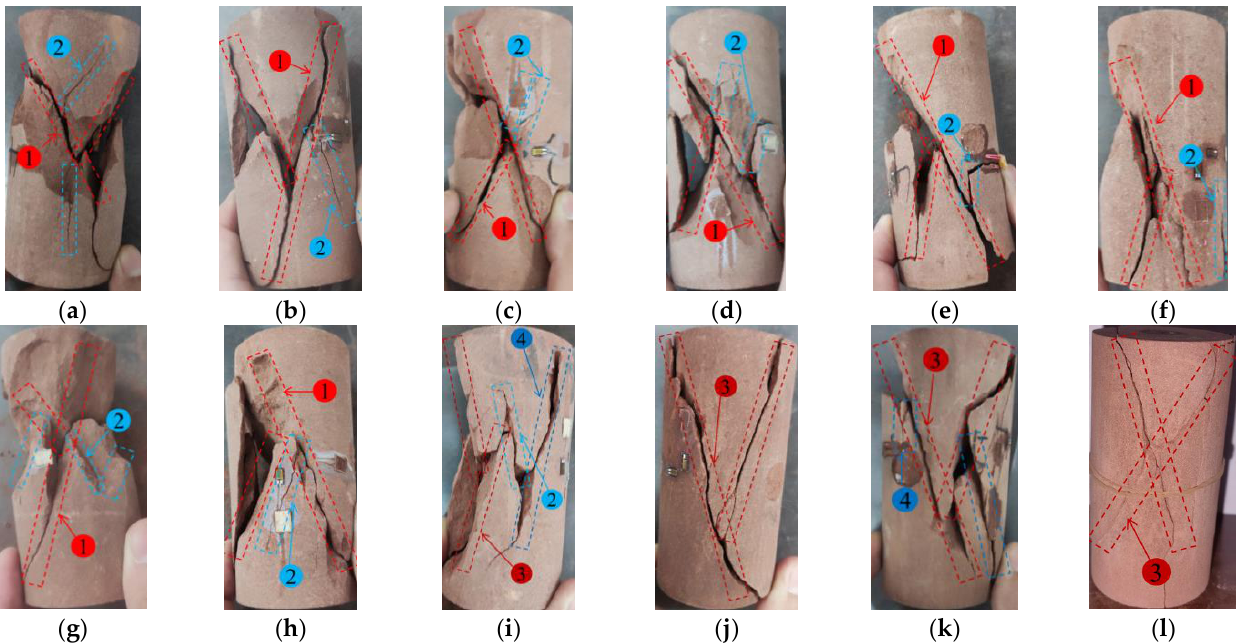
Figure 11. Re-bearing and uniaxial damage characteristics of pre-peak unloading sandstone: (1) newborn primary crack; (2) newborn secondary crack; (3) secondary primary crack; (4) secondary secondary crack.